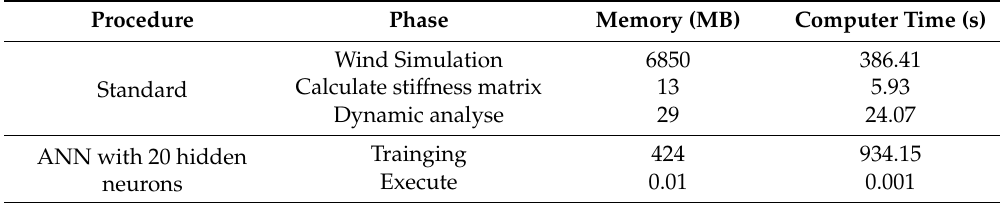
Table 5. Memory and computer time in order to process the tasks of the case: H = 150